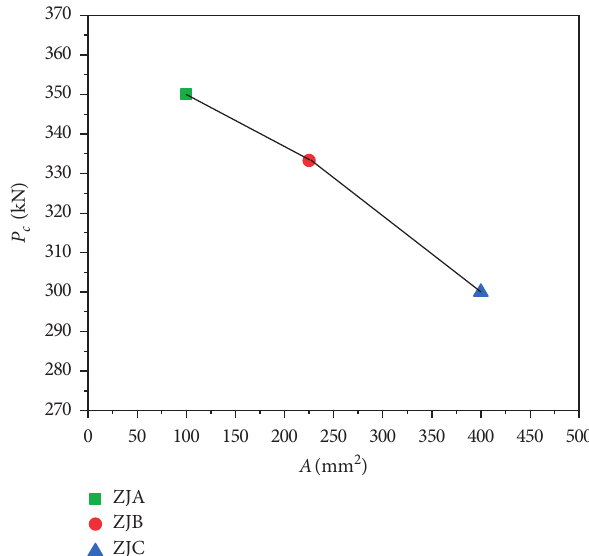
Figure 10: Cross-sectional area of a bamboo bar and cracking load